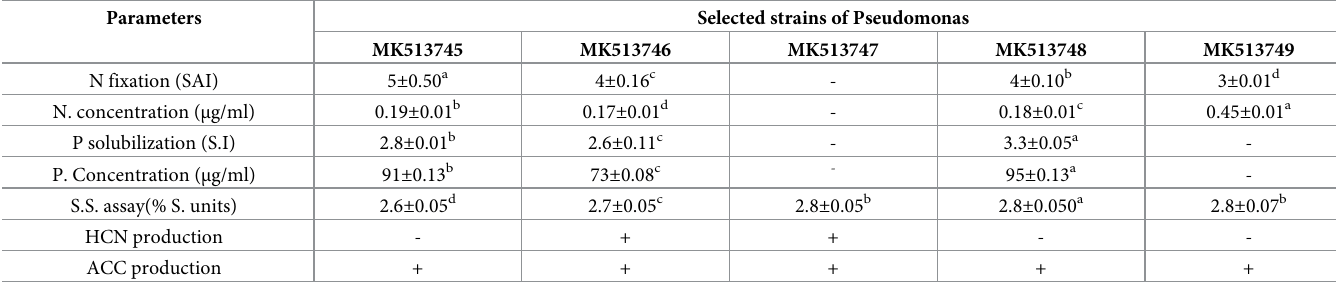
Table 2. PGP characterization of selected strains of Pseudomonas aeruginosa .